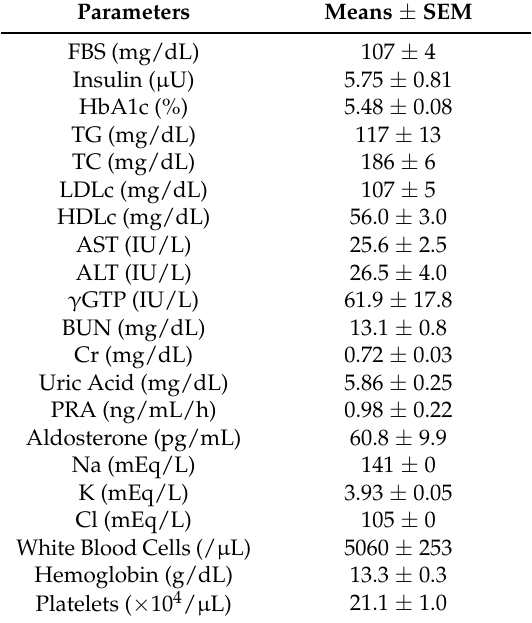
Table 2. Laboratory data of all patients at baseline.